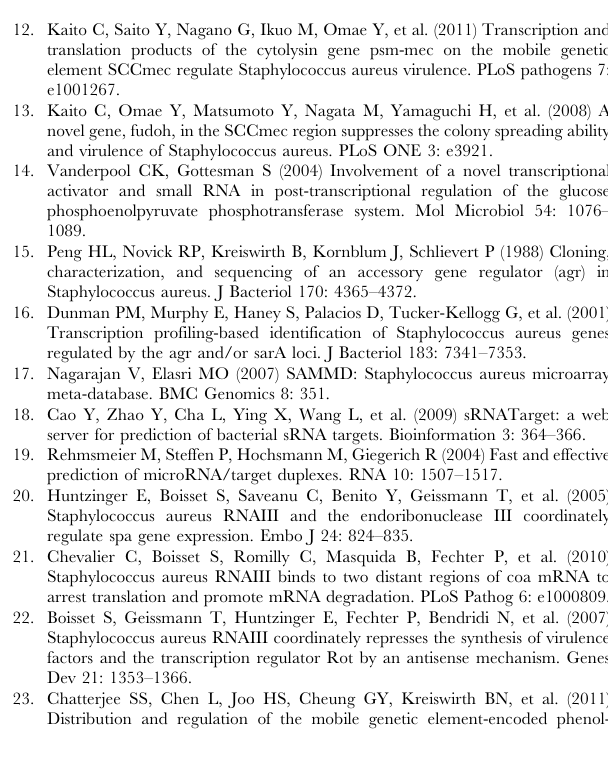
Figure S5 Expression of mecA in the psm-mec- deleted mutants of clinical isolates. Northern blot analysis was performed to detect mecA mRNA in the psm-mec- deleted mutants and clinical isolates. Total RNA was extracted from cultures at the log phase (A 600 =0.5) and electrophoresed. rRNA stained with ethidium bromide is shown. Data are representative from three independent experiments. (TIF) Figure S6 Virulence of the psm-mec -deleted mutants of MSA890 and Sanger252 in a mouse systemic infection model. ICR mice (n= 10) were intravenously injected with S. aureus cells. Injected CFUs were as follows: MSA890 and its psm-mec -deleted mutant, 2 6 10 8 CFU; Sanger252 and its psm-mec -deleted mutant, 2 6 10 8 CFU. Log-rank test P-value between MSA890 and its psm-mec- deleted mutant is 0.0489. Table S1 Identification of proteins upregulated by psm-mec RNA in the FRP3757 strain. Table S2 Primers used in the